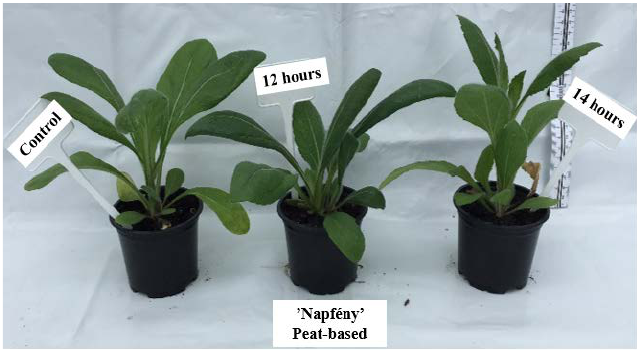
Figure 8. 11 weeks-old Rudbeckia hirta ’Napfény’ plantlets depending on photoperiodic lighting treatments in peat-based media (University of Debrecen, Biological Research and Plant Experiment Greenhouse - Biodrome, Debrecen, Hungary, 2021).